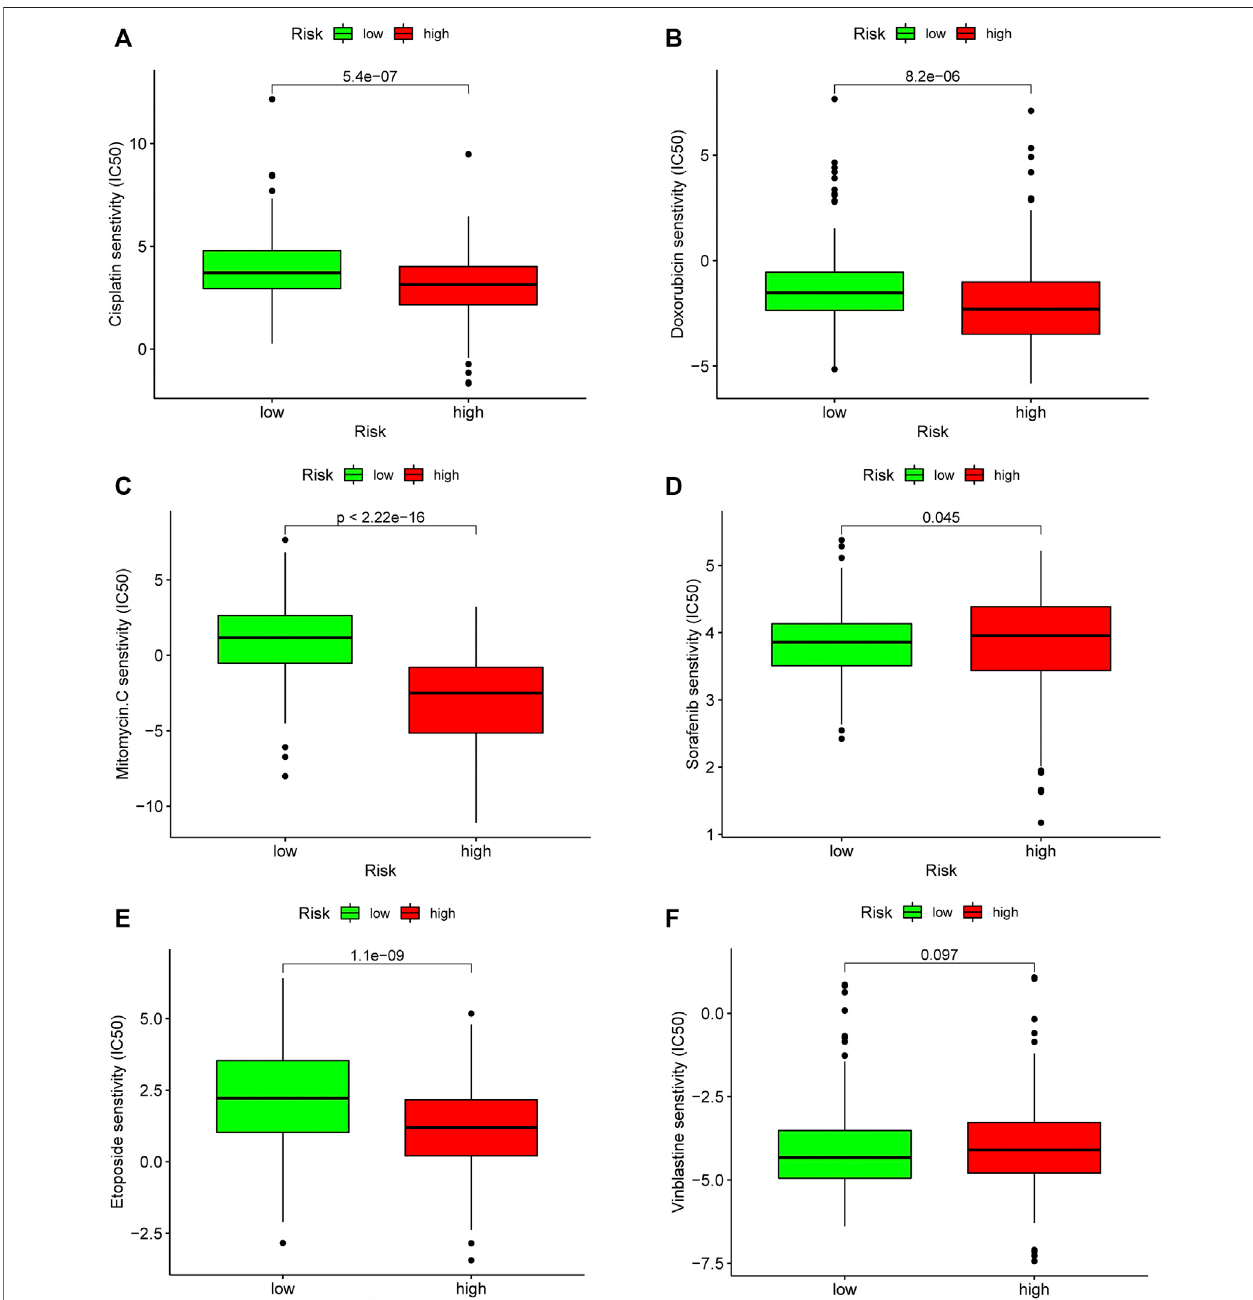
FIGURE9| Evaluationofchemosensitivitybytheriskmodel.ThemodelshowedhighriskscoreswereassociatedwithalowerIC50forchemotherapeuticssuchas (A) cisplatin, (B) doxorubicin, (C) etoposide, and (E) mitomycin C, whereas they were related to a higher IC50 for (D) sorafenib.